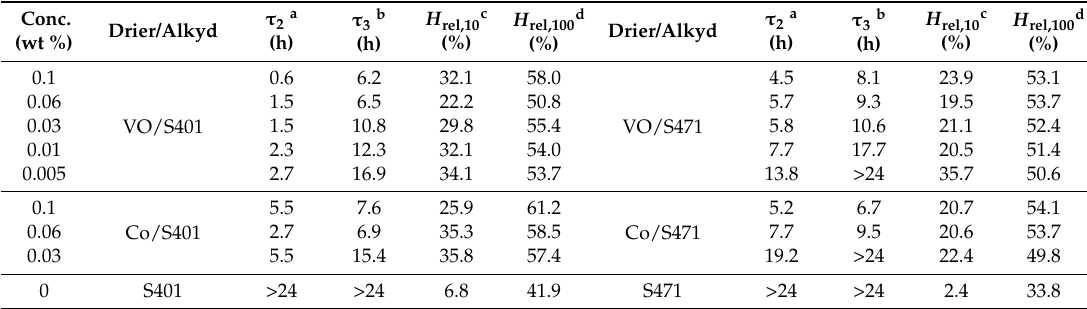
Table 1. Drying times and relative hardness of alkyd films dried with VO and